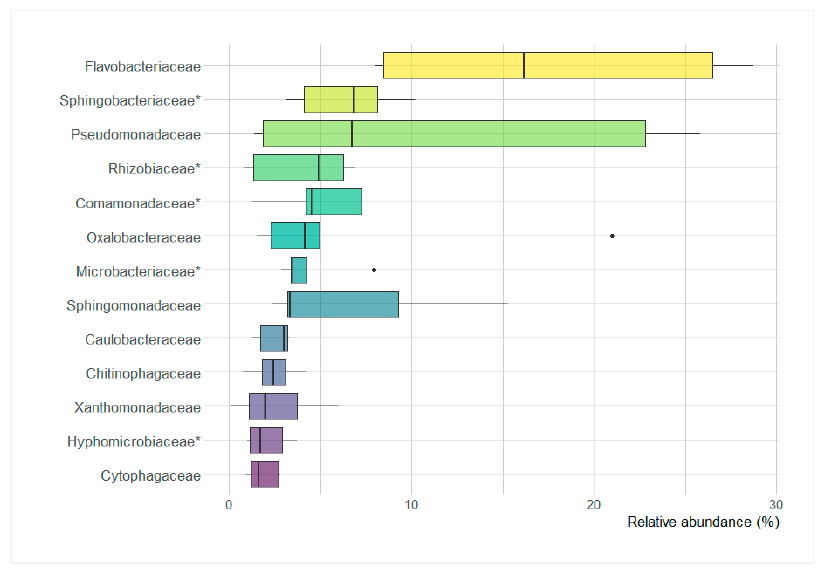
Figure 8. Boxplots displaying the range of relative sequence abundance of major Poa annua root- dwelling bacterial families. * significantly enriched in the endosphere compared to the rhizo- sphere.